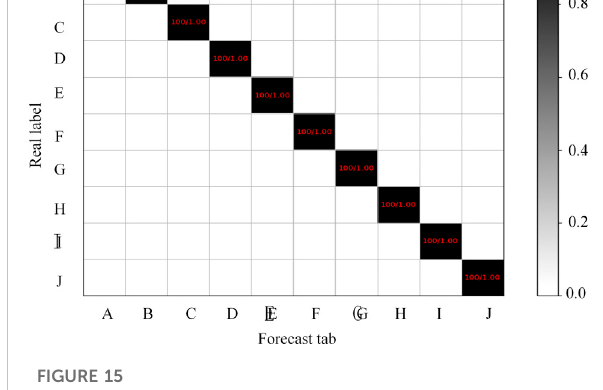
FIGURE 15 Disturbance matrix of transformer sound winding short circuit identi fi cation.